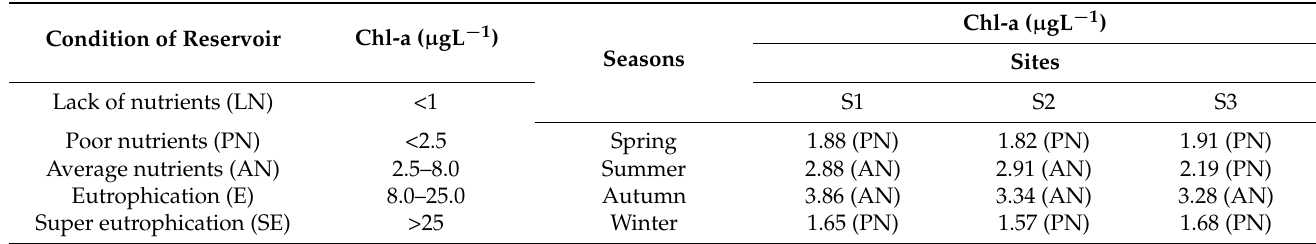
Table 2. Nutrient classification of Andong Reservoir according to OECD